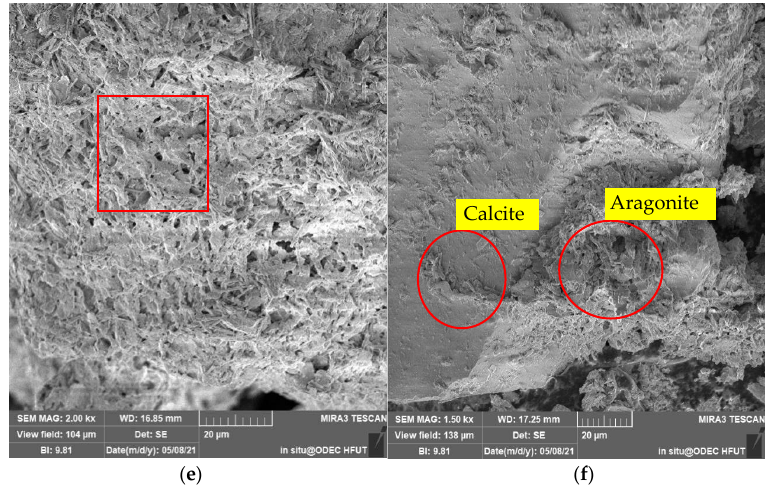
Figure 11. SEM results for classic samples after 0–6 rounds of grouting: ( a ) control group 2000 × magnification; ( b ) B1 5000 × magnification; ( c ) C1 5000 × magnification; ( d ) E1 2000 × magnification; ( e ) E1 2000 × magnification; ( f ) F1 1500 × magnification.